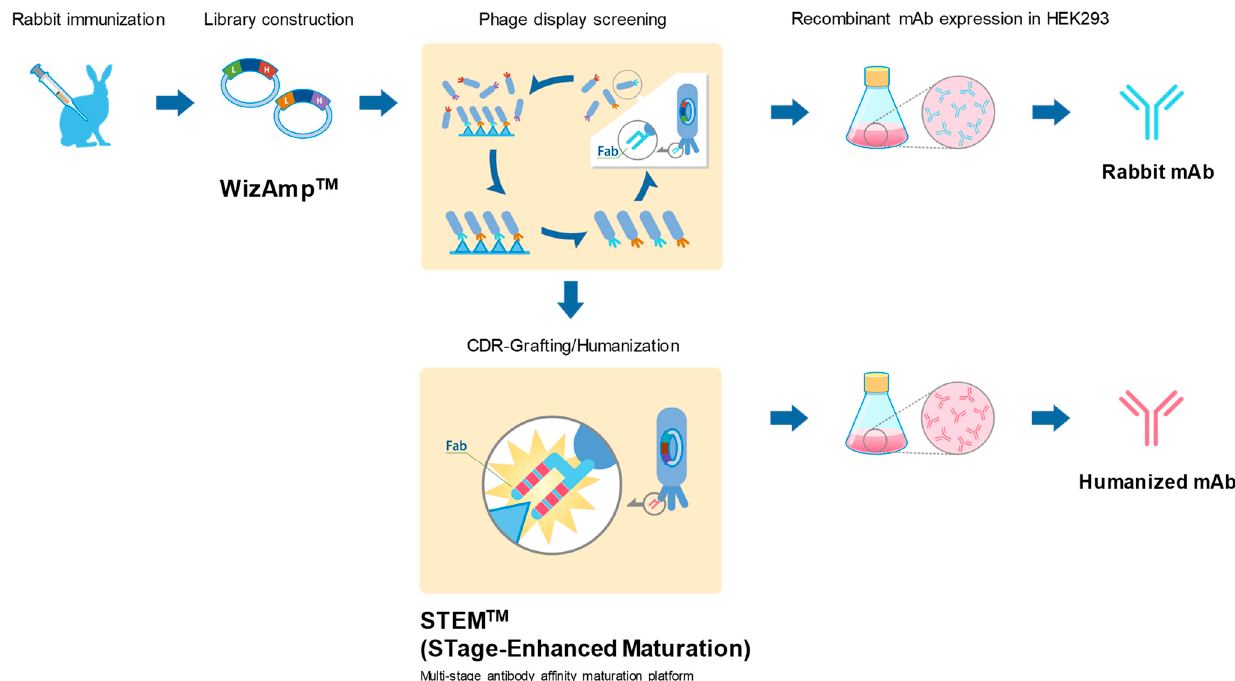
Figure 1. Overview of antibody production procedure .